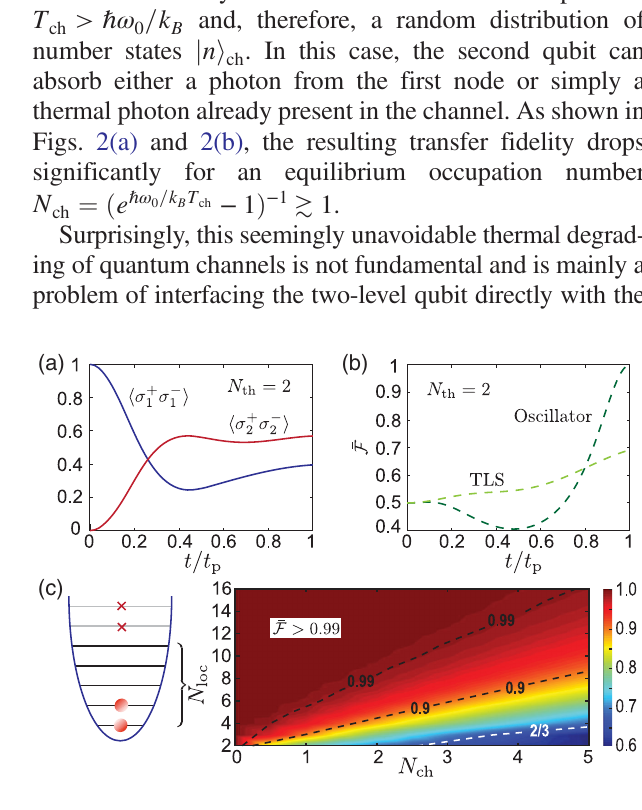
≡ σ − FIG. 2. (a) Occupation number of qubits 1 and 2 ( L ) . i ch i during the evolution generated by H in Eq. (3) and for a thermal int 2 of the channel mode. (b) Comparison of the occupation N ch ¼ ¯ F average fidelity for quantum states encoded locally in a two- t Þ , level system (TLS) and a harmonic oscillator. (c) Average transfer i ð fidelity for the case, where the dynamics of the local oscillators is restricted to the N lowest number loc